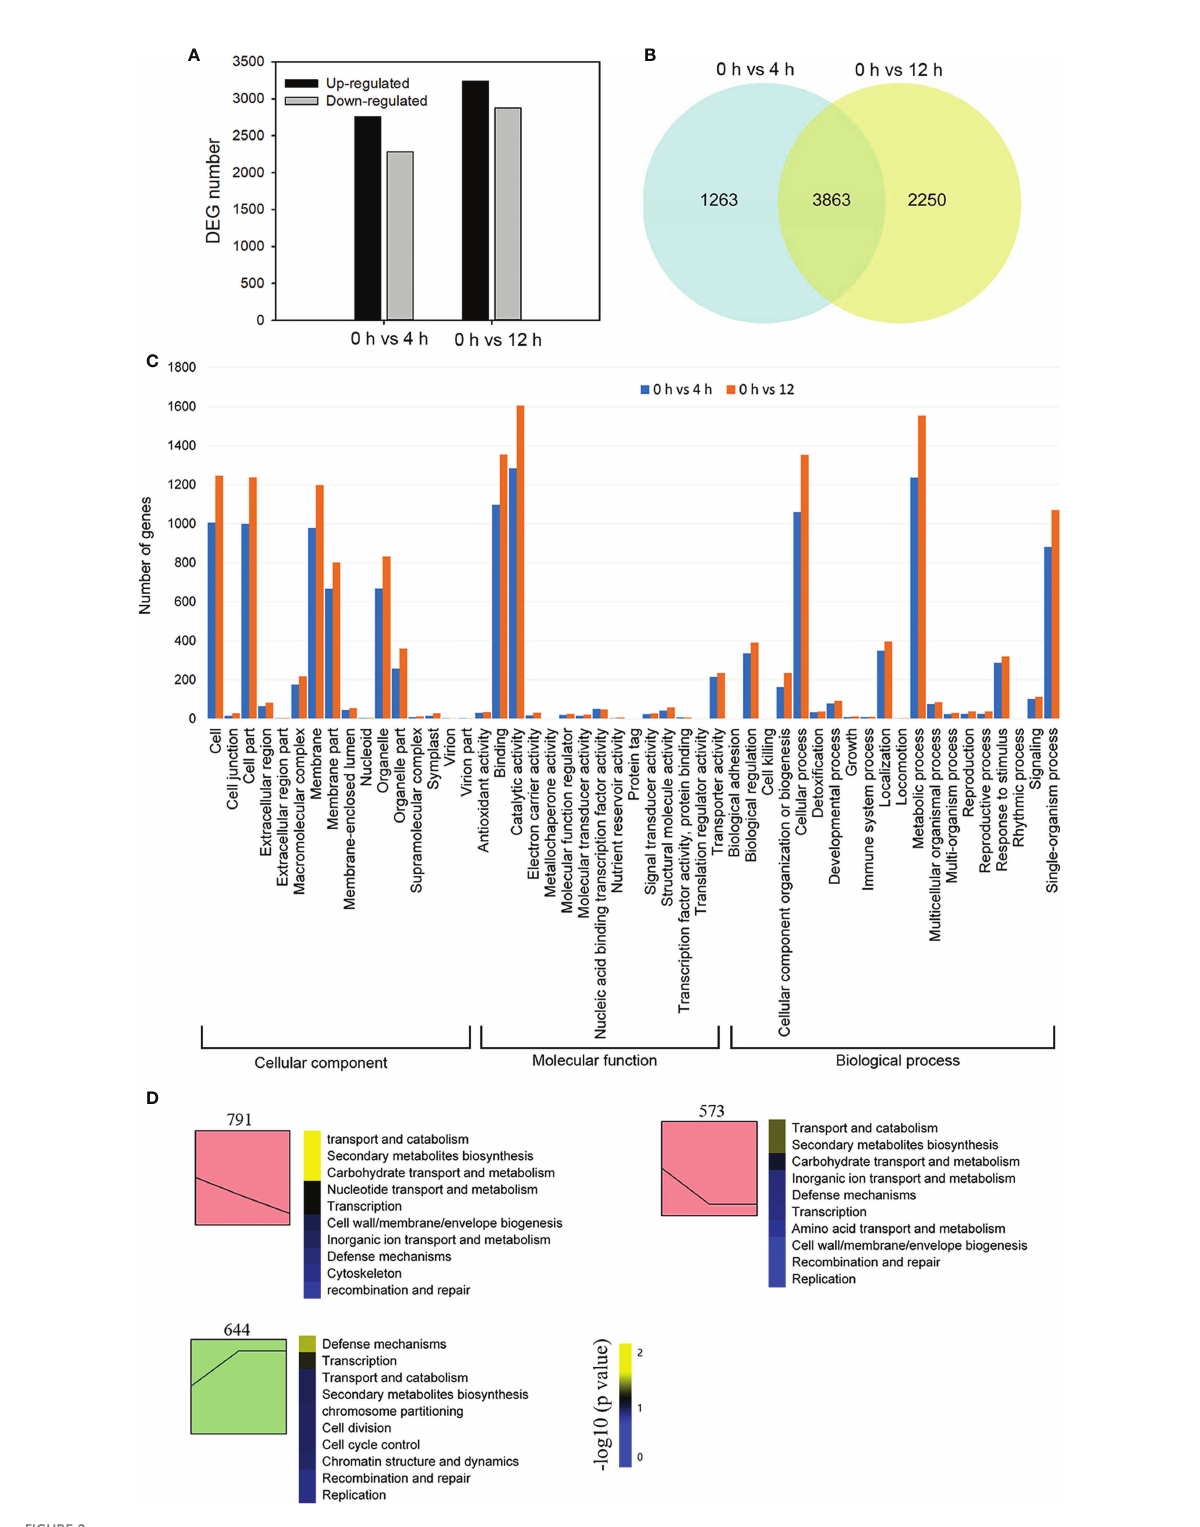
FIGURE 2 Transcriptome sequencing analysis of Dendrobium of fi cinale plantlet roots after salt treatment. (A) Analysis of differentially expressed genes (DEGs) in response to salt tress. DEGs were generated by 0 h vs 4 h and 0 h vs 12 h comparisons. (B) Venn diagram showing shared DEGs from the 4 h and 12 h comparison after salt stress. (C) Gene ontology analysis of DEGs. (D) All DEGs were subjected to STEM clustering